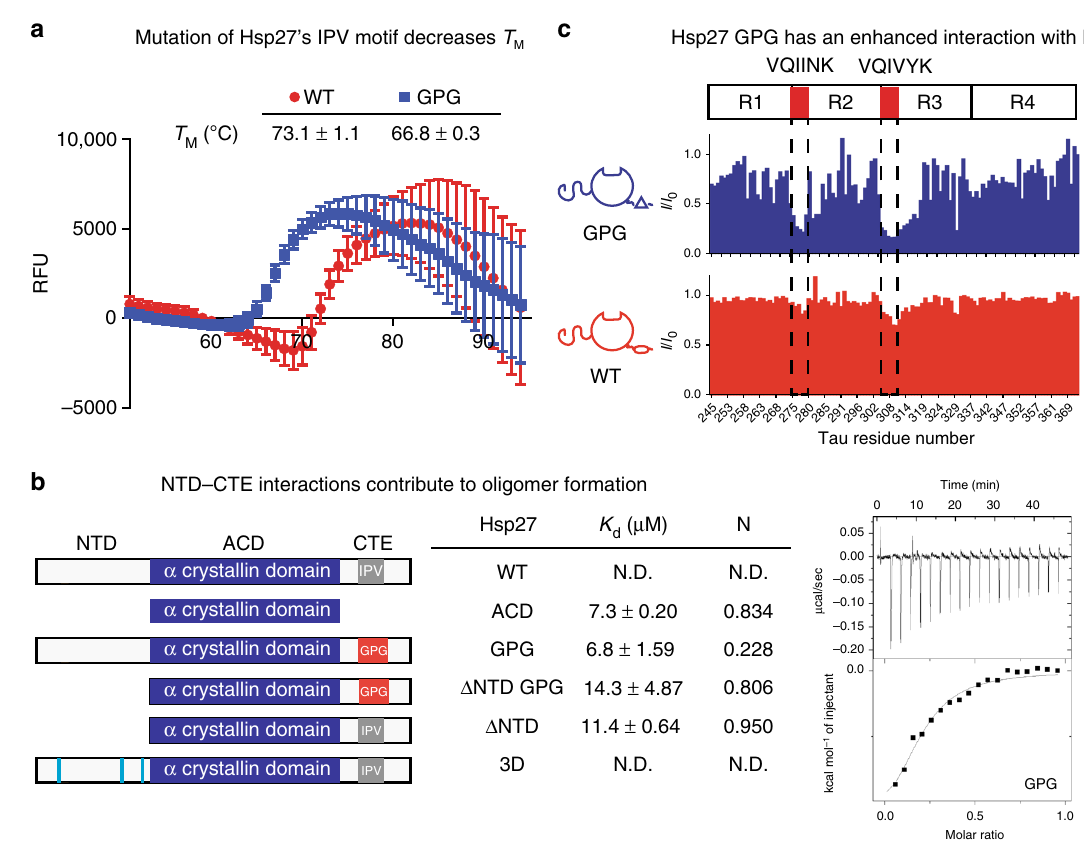
Fig. 4 The β 4/ β 8 groove is a regulatory site of sHSP oligomerization and function. a Differential scanning fl uorimetry melting curves of Hsp27 WT and GPG. Data points are the mean ± SEM of three technical replicates. Listed melting temperatures are the mean ± SD of three independent experiments. b ITC binding experiments of optimized IPV peptide with listed constructs of Hsp27. Left, cartoon representation of Hsp27 constructs used in this experiment. Middle, table of af fi nity and stoichiometry values obtained from ITC experiments. Values in table are mean ± SEM determined from a minimum of three independent experiments. Right, representative ITC curve of peptide binding to Hsp27 GPG. c Intensity ratios of 15 N K18 in the presence of 100 μ M Hsp27 WT or GPG (2:1 molar